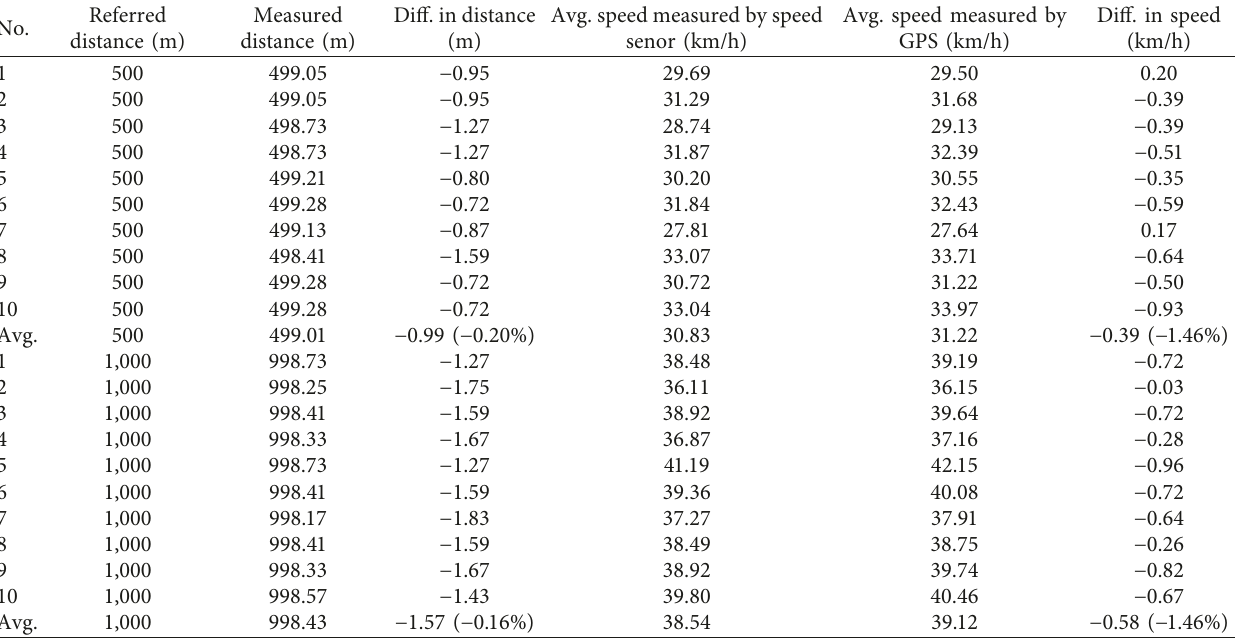
Table 5: Validation results of Hall effect sensor for measuring